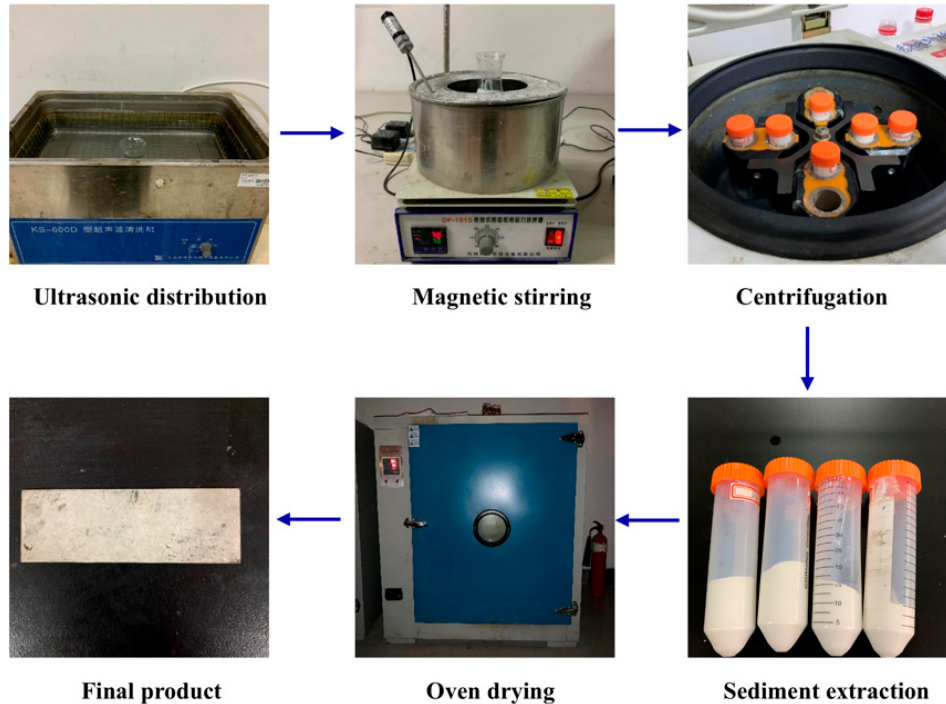
Figure 5. The procedures for sample